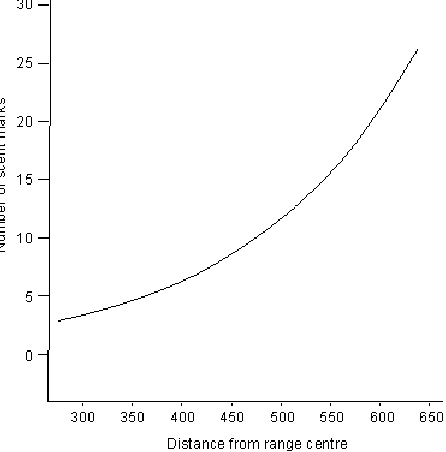
Figure 4 The effect of the distance from the centre of the studied klipspringer range on the number of scent marks produced by these klipspringer in the Kruger National